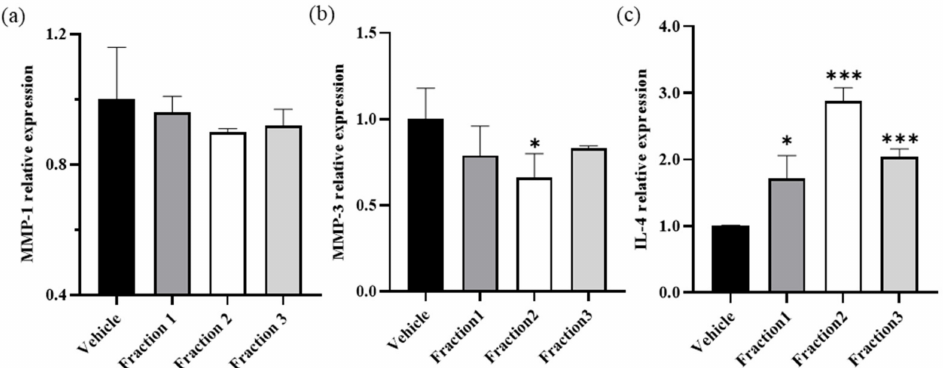
Figure 3. Effects on the mRNA expression levels of ( a ) MMP-1, ( b ) MMP-3, and ( c ) IL-4 in human fibroblast CCD-986sk cells following treatment with three I. indigotica leaf fractions. CCD-986sk cells were incubated in 5% CO 2 at 37 ◦ C, and then the three I. indigotica leaf fractions dissolved in dimethyl sulfoxide (5 µ g/mL) were transferred into the cells for 24 h. The mRNA levels after treatment with the three fractions were assayed using real-time polymerase chain reaction. Data were obtained through three independent replicates. * and *** indicate significant differences at 0.05 and 0.001 significance level,